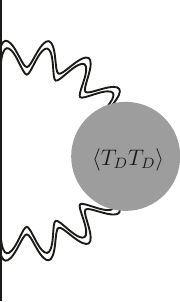
Figure 1 . Brane-localized modes interact with matter Dirichlet modes in the presence of gravity, therefore (cid:0) = ~(cid:0). T D denotes the stress tensor of Dirichlet 6